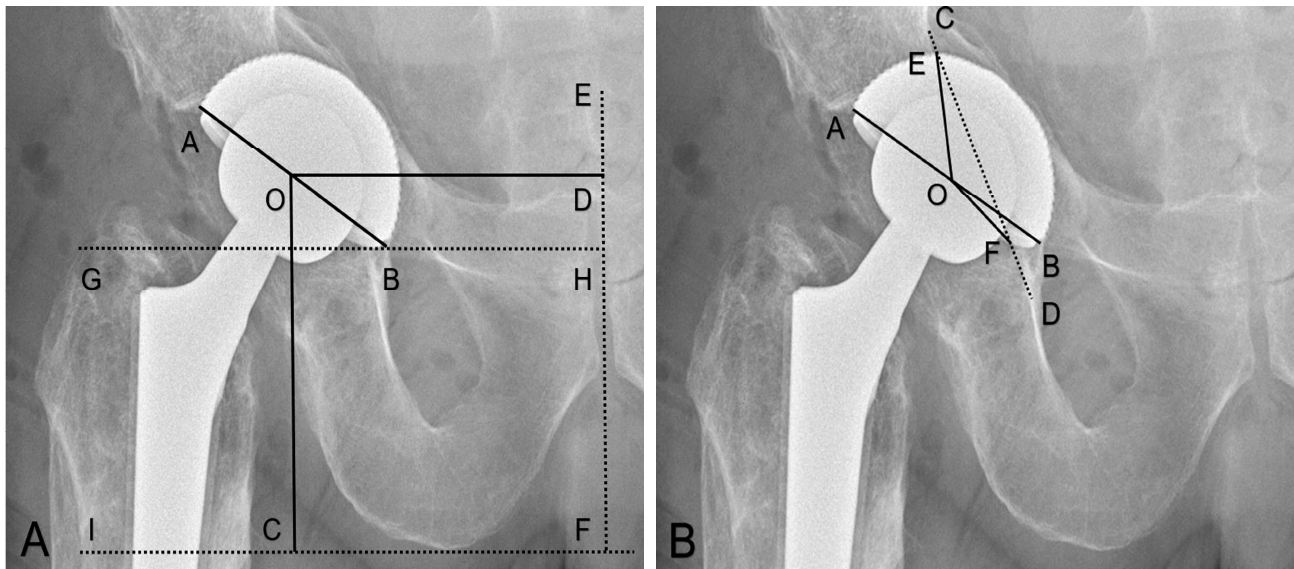
Figure 1. (A ). O as the center of the femoral head, OD as the horizontal distance from the horizontal center of rotation (H-COR) to the EF midline (perpendicular line to the IF ischial tuberosity line positioned on the symphysis). OC as vertical center of rotation (V-COR) was defined as the vertical distance from the center of the femoral head to the IF ischial tuberosity line [24]. ∠ ABG° as inclina- tion was defined as the angle between the parallel line to the ischial tuberosity line and the plane of the opening of the acetabular component [23]. ( B ). Rate of the medial protrusion ( ∠ EOF°/180°) × 100% [26]. O as the center of the femoral head. AB as the diameter of the cup. CD as the ilioischial line. Point E and point F are the intersections between the medial edge of the acetabular component and the ilioischial line.